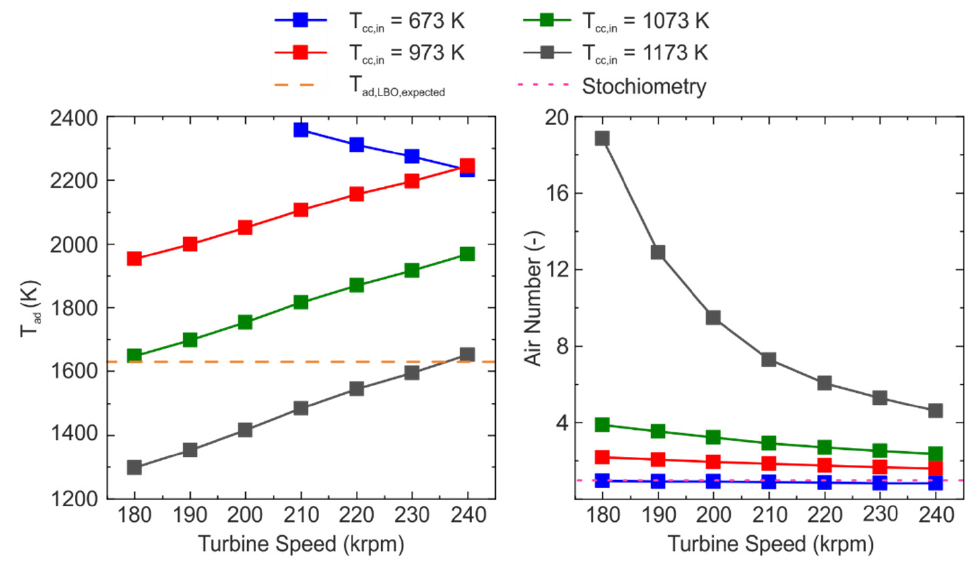
Figure 6. Adiabatic flame temperature and air number for a primary air ratio of PAR = 20% for different combustion chamber inlet temperatures .